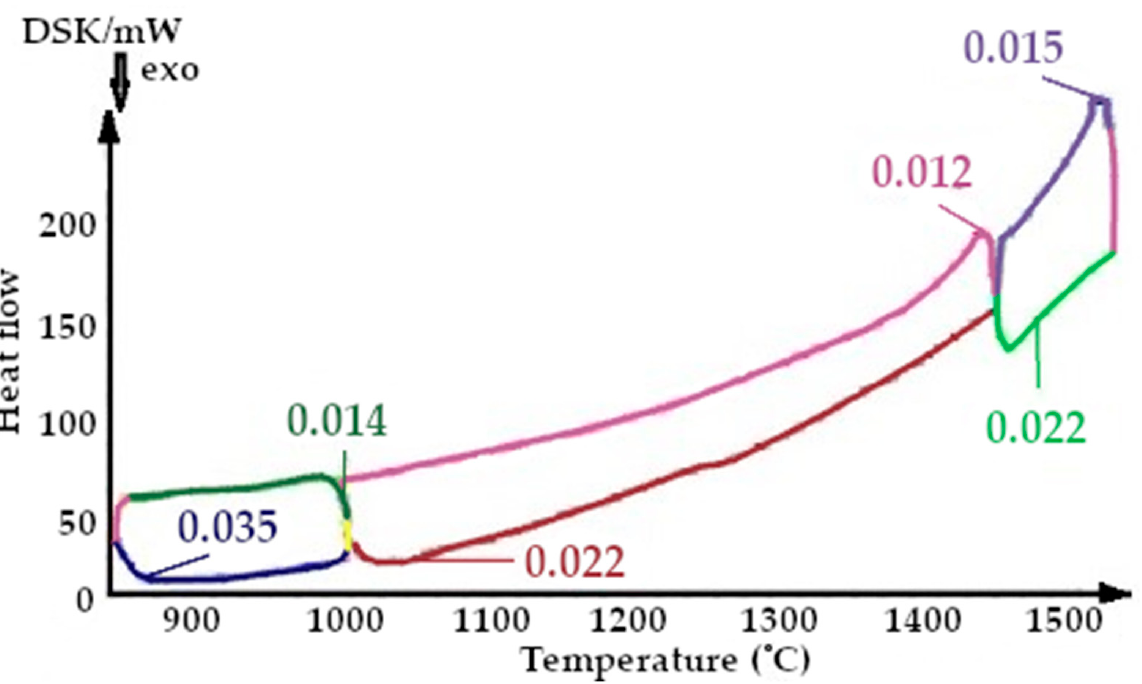
Figure 13. Fragment of the thermogram of quartzite, calcified at a temperature of 200 °C (Cycle 3), where: